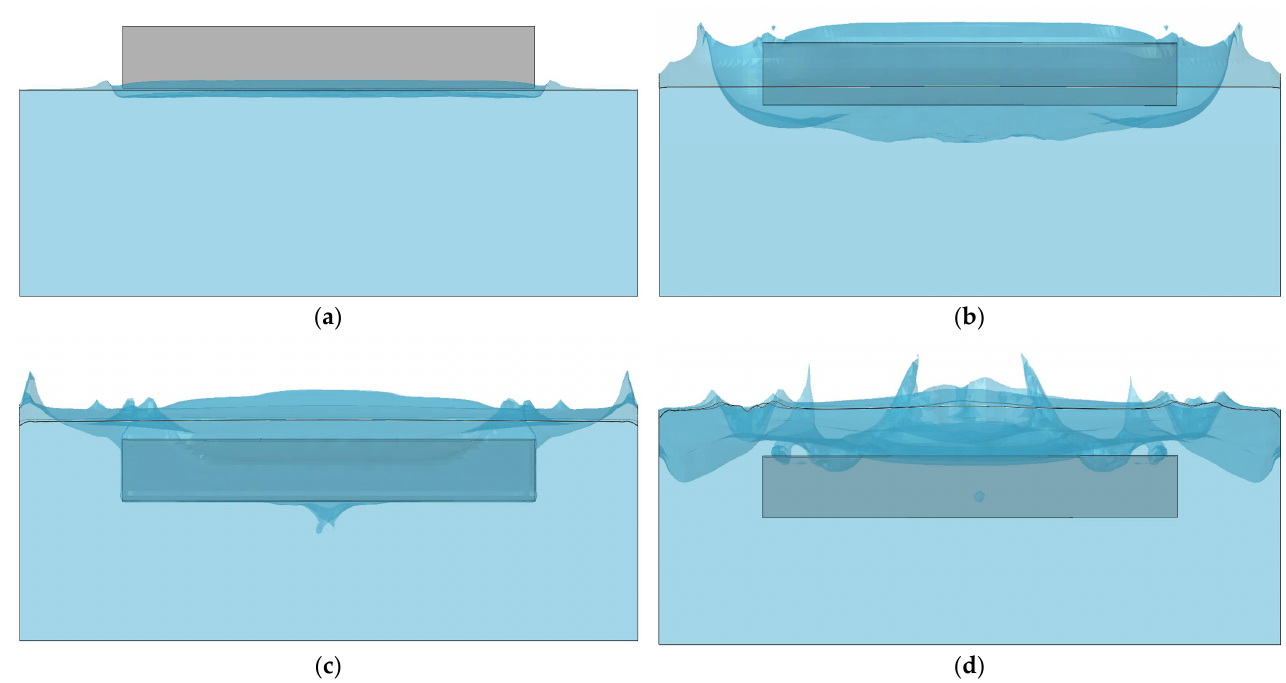
Figure 8. Images of water–steel box interaction in CEL analysis ( h : 2 m; t : 3 mm).